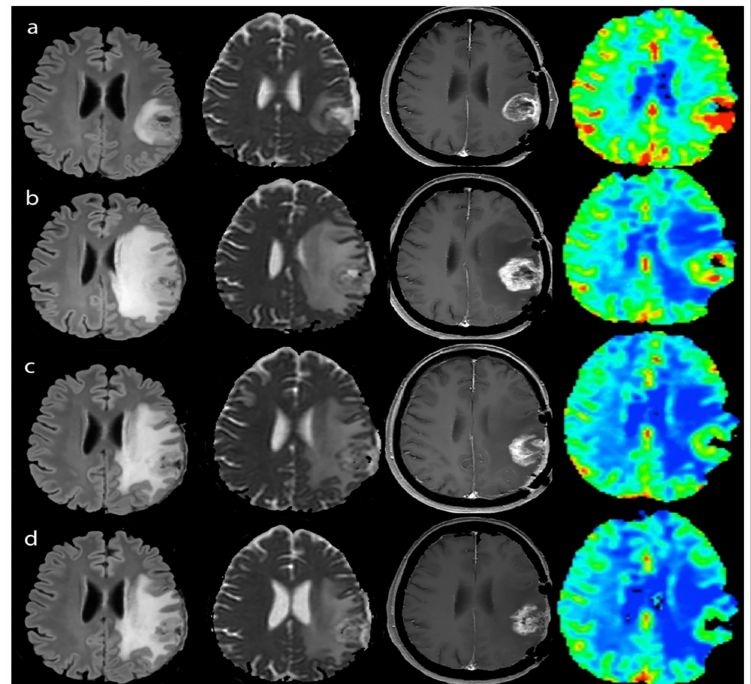
Figure 3. Pseudoprogression during immunotherapy of a LowNK and hypermethylated case - Left to right: FLAIR, ADC map, T1-enhanced and CBV map. ( a ) Jan 2015, MRI-pre, after surgery and radio-chemotherapy (steroid dose 2 mg Dexamethazone, clinical condition stable): GBM showing contrast enhancement (T1) and hyper-perfusion with high CBV (red-colored), slight edema (FLAIR) and non-homogeneous ADC restriction as in hypercellularity; ( b ) Mar 2015, MRI-2 mo during immunotherapy (no steroid therapy, clinical condition stable): enlargement of enhancing volume and of edema with mass e ff ect and reduction of hyper-perfusional intensity (yellow to green CBV with small red spots) and persistent ADC un-homogeneity; ( c,d ) Jun and Aug 2015, MRI-4 and -6 mo after immunotherapy (no steroid therapy clinical condition stable): reduction of enhancing volume, edema and CBV intensity (green) and volume of hyper-perfusion with less restricted